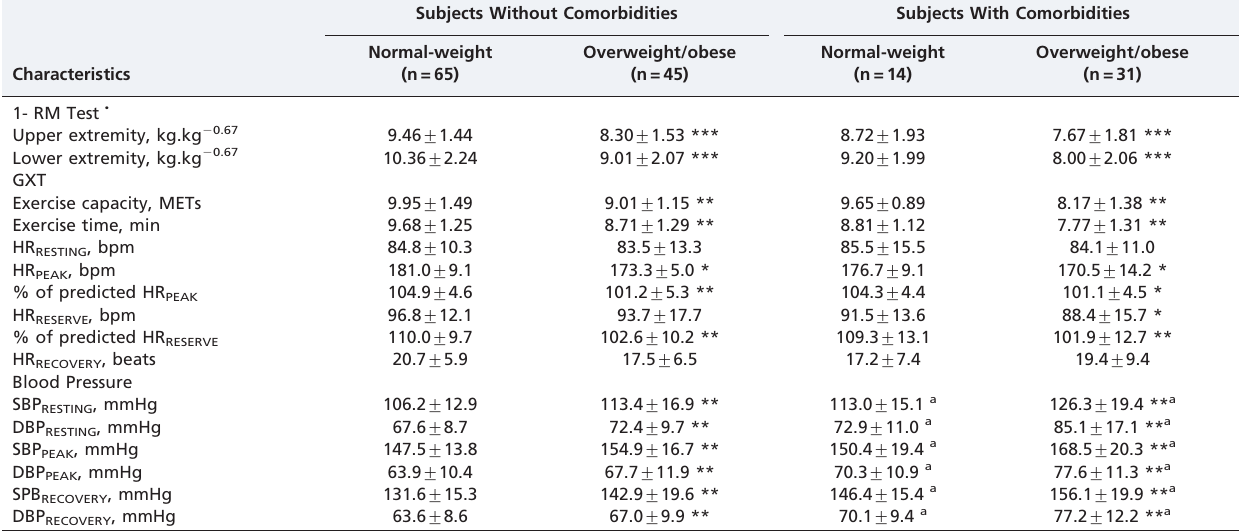
(BMI = 29.2 ¡ 3.0 vs . 29 ¡ 2.9, P = 0.419; waist circumference = 97.4 ¡ 10.6 vs . 95.8 ¡ 9.3, P= 0.44) groups. Data from the GXT and 1-RM tests of the women completing the exercise training program before and after the 12-month follow-up are presented in Table 4. Both groups improved upper (39.4%) and lower (49.6%) Table 3 - Baseline muscle strength, cardiorespiratory fitness, heart rate and blood pressure responses to exercise in women with or without comorbidities. 1-repetition maximum strength test was adjusted for body